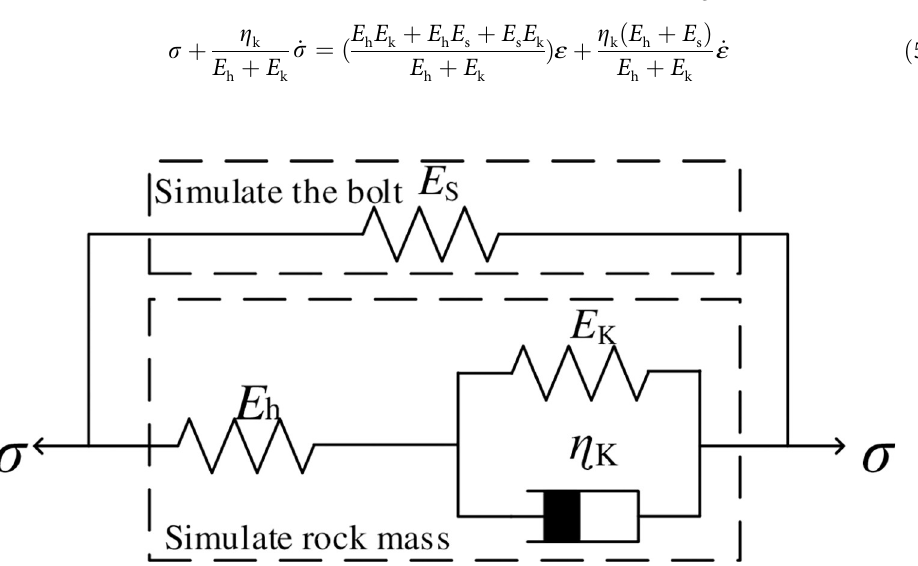
Fig 10. Coupling model of the anchorage rock